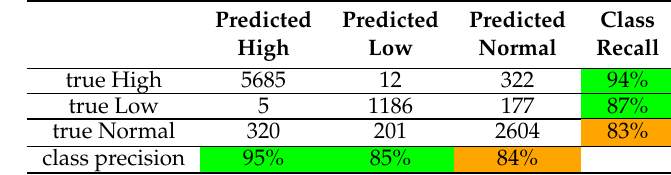
Table 4. Confusion matrix for DT.